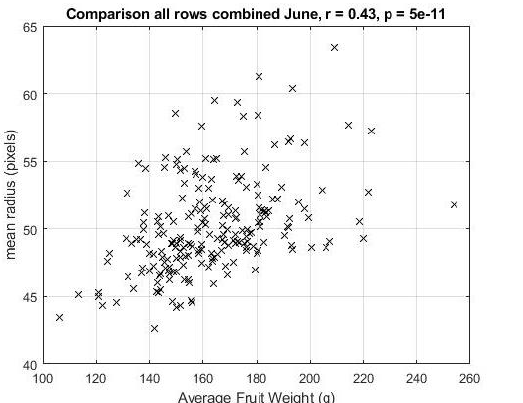
Figure 10. Scatter plot of predicted average fruit radius in pixels versus the average harvested fruit weight, over all